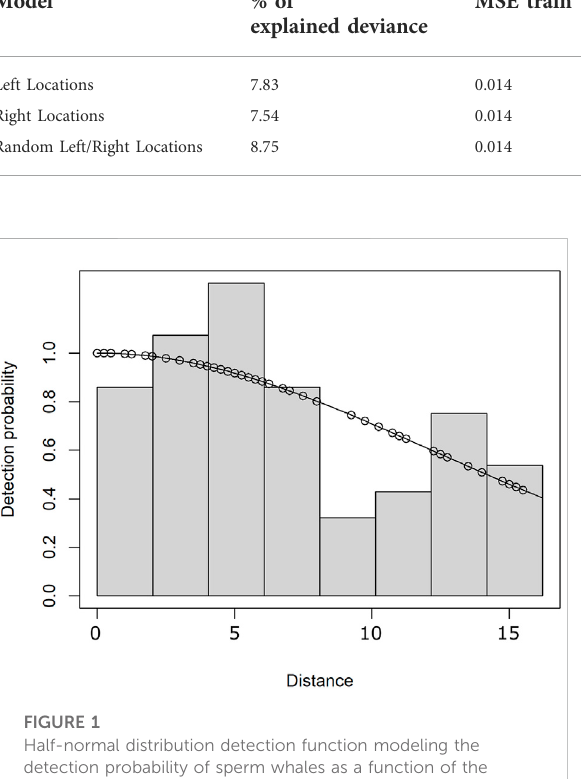
FIGURE 1 Half-normal distribution detection function modeling the detection probability of sperm whales as a function of the distances estimated from the localized acoustic encounters (open